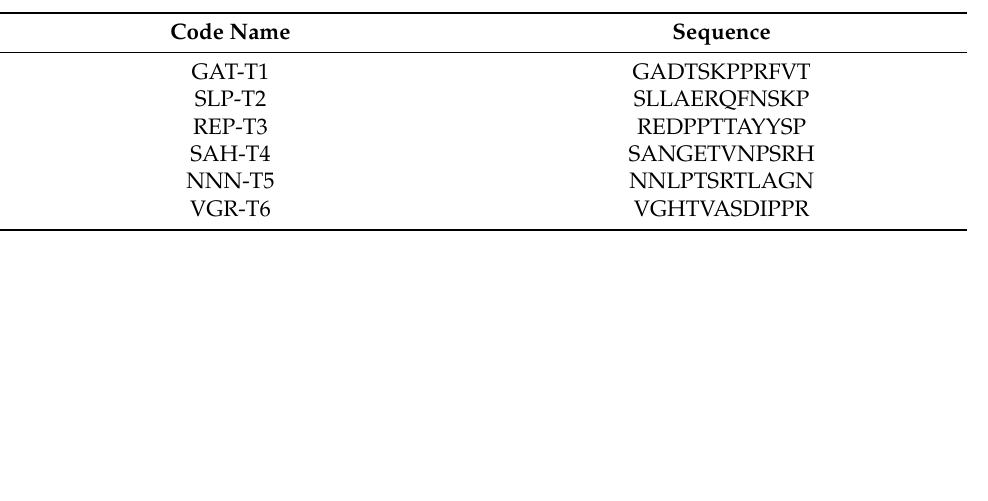
Table 2. The code name and corresponding sequence of specific